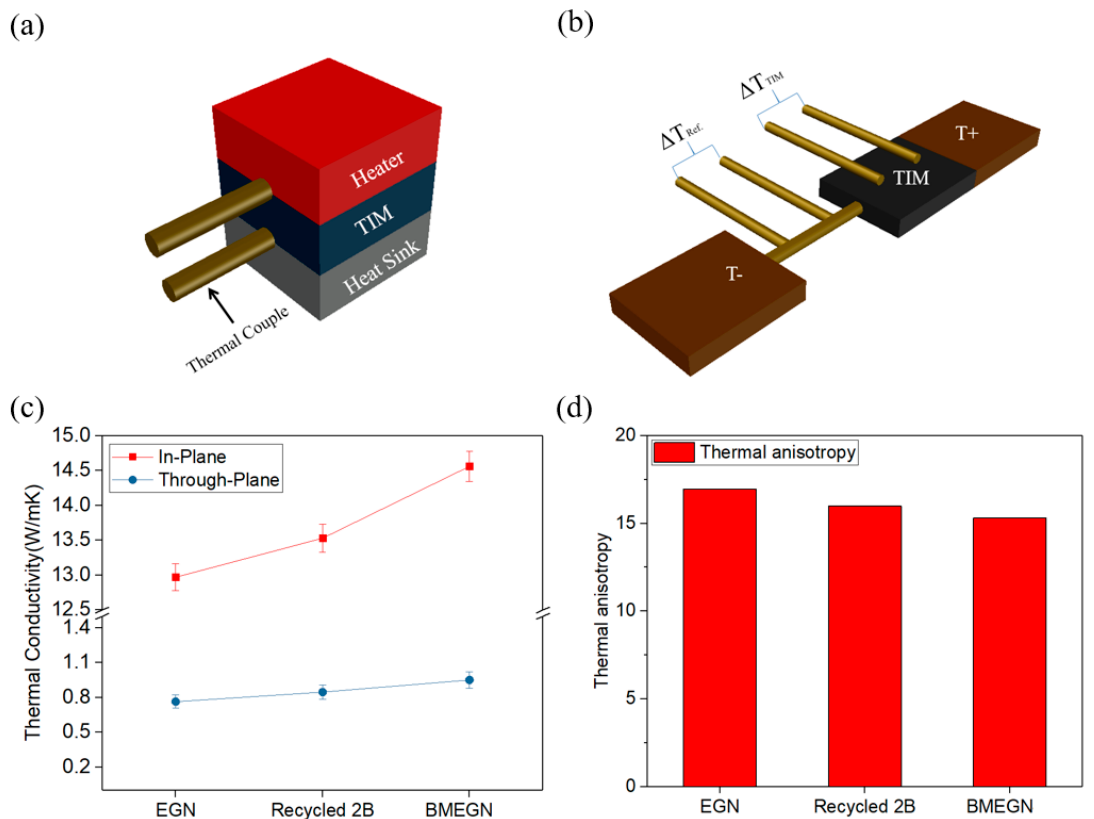
Figure 7. ( a ) Measurement setups of thermal conductivity in the through-plane ( K ┴ ) and ( b ) in-plane ( K // ); ( c ) measurement results of EGN, recycled 2B and BMEGN composites; ( d ) calculated anisotropy values ( K // / K ┴ ).